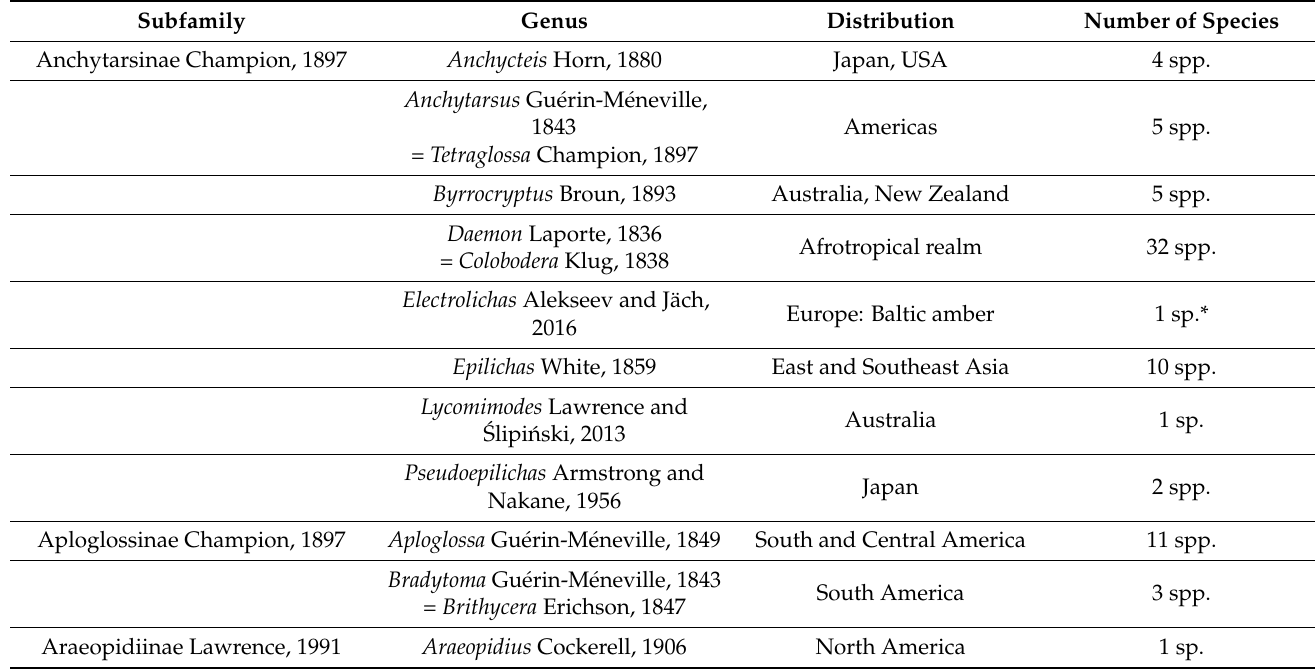
Table A1. Classification, diversity, and distribution of Ptilodactylidae. Most genera are in urgent need of revision so the generic classification and numbers of described species may change dramatically in future, also considering the undescribed genera reported by Stribling [32]. * = extinct